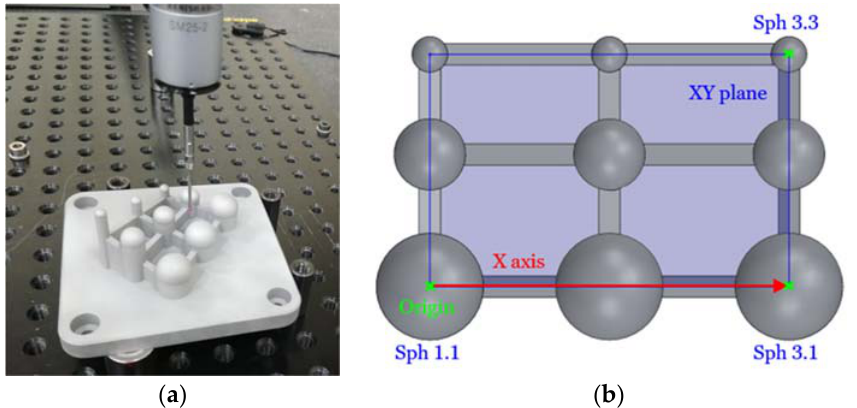
Figure 4. ( a ) Contact measurement of the test part; ( b ) alignment features of the test part.